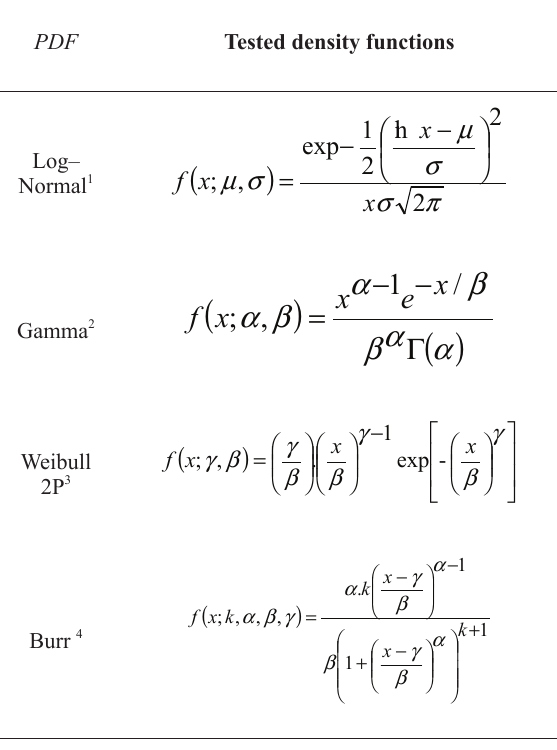
empirical statistical expression for the diameter distribution of the stand and